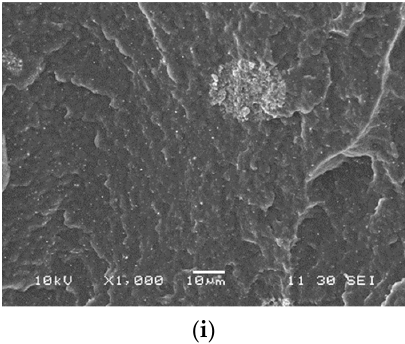
Figure 2. Detection and characterization of aggregation in PCL/halloysite composites by scanning electron microscopy. Halloysite content, technology, and magnification: ( a ) 5 vol%, film, 1000×; ( b ) 5 vol%, film, 2000×; ( c ) 5 vol%, film, 5000×; ( d ) 5 vol%, film, 2000×; ( e ) 5 vol%, compressed, 2000×; ( f ) 5 vol%, melt mixed, 2000×; ( g ) 1 vol% melt mixed, 1000×; ( h ) 5 vol%, melt mixed, 1000×; ( i ) 10 vol%, melt mixed, 1000×.